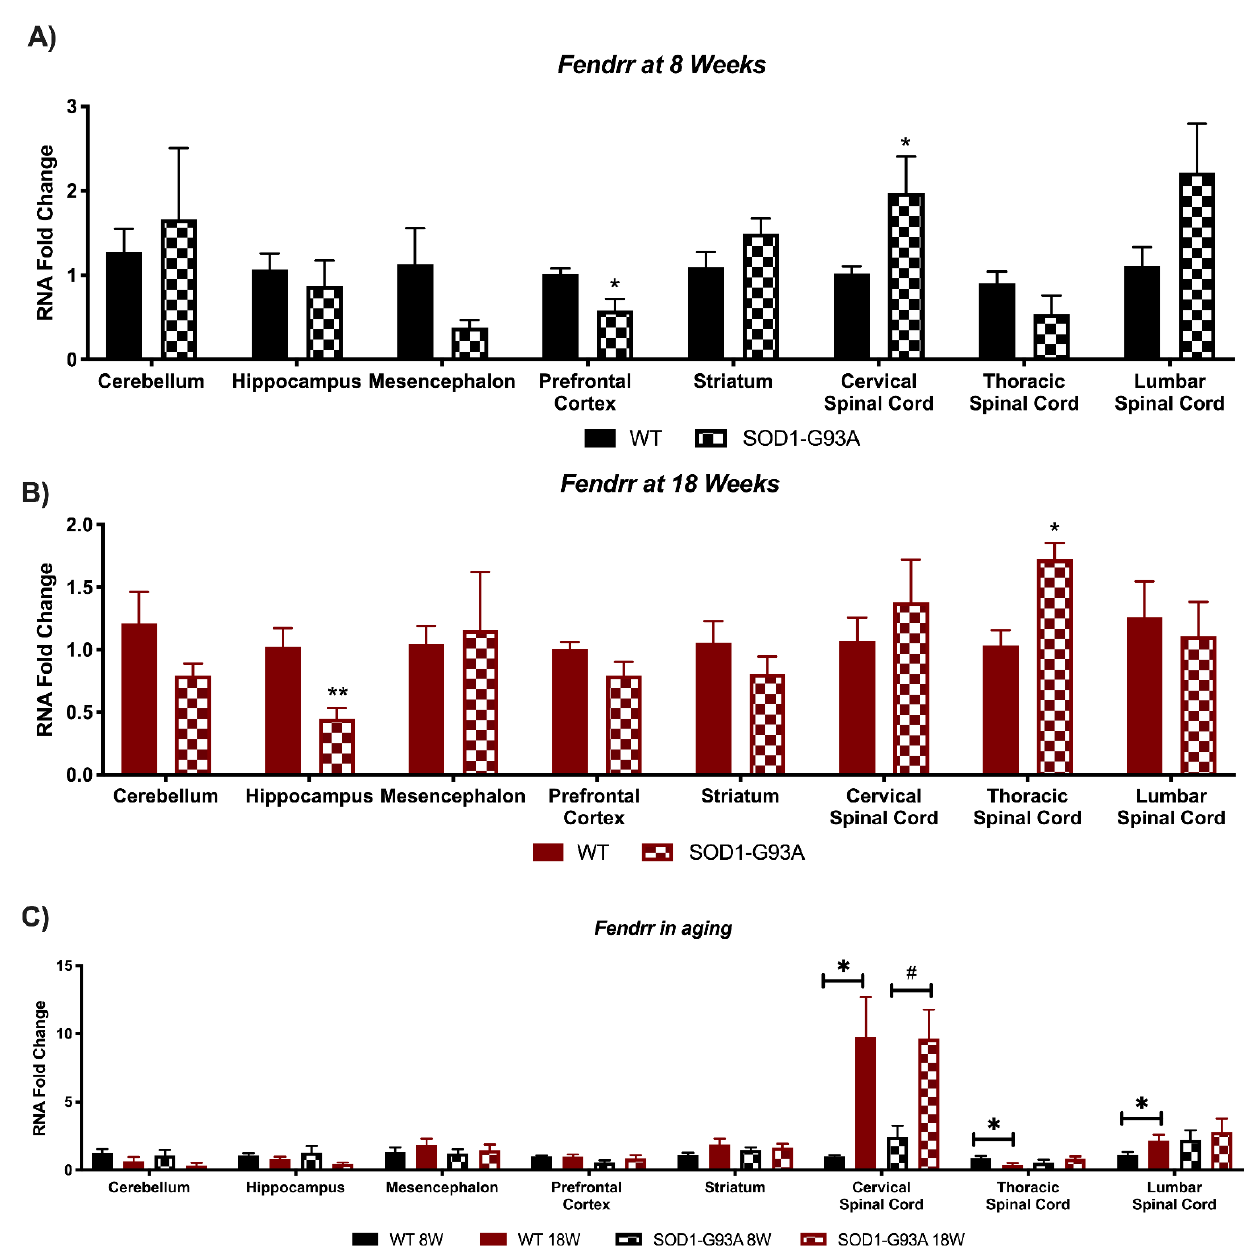
Figure 8. Analysis of Fendrr expression shows strong perturbations in SOD1-G93A mice. RNAs expression levels were evaluated by Real Time-PCR in the different conditions. Data are expressed as mean ± SEM. ( A ) Fendrr expression in 8 weeks old WT ( n = 6) mice versus 8 weeks old SOD1-G93A mice ( n = 6). * p < 0.05 vs. WT. ( B ) Fendrr expression in 18 weeks old WT ( n = 6) mice versus 8 weeks old SOD1-G93A mice ( n = 6). * p < 0.05, ** p < 0.01 vs. WT. ( C ) Fendrr expression in 8 weeks old WT mice versus 18 weeks old WT ( n = 6) and 8 weeks old SOD1-G93A mice versus 18 weeks old SOD1-G93A mice ( n = 6). * p < 0.05 vs. WT 8W, # p < 0.05 vs. SOD1-G93A 8W.